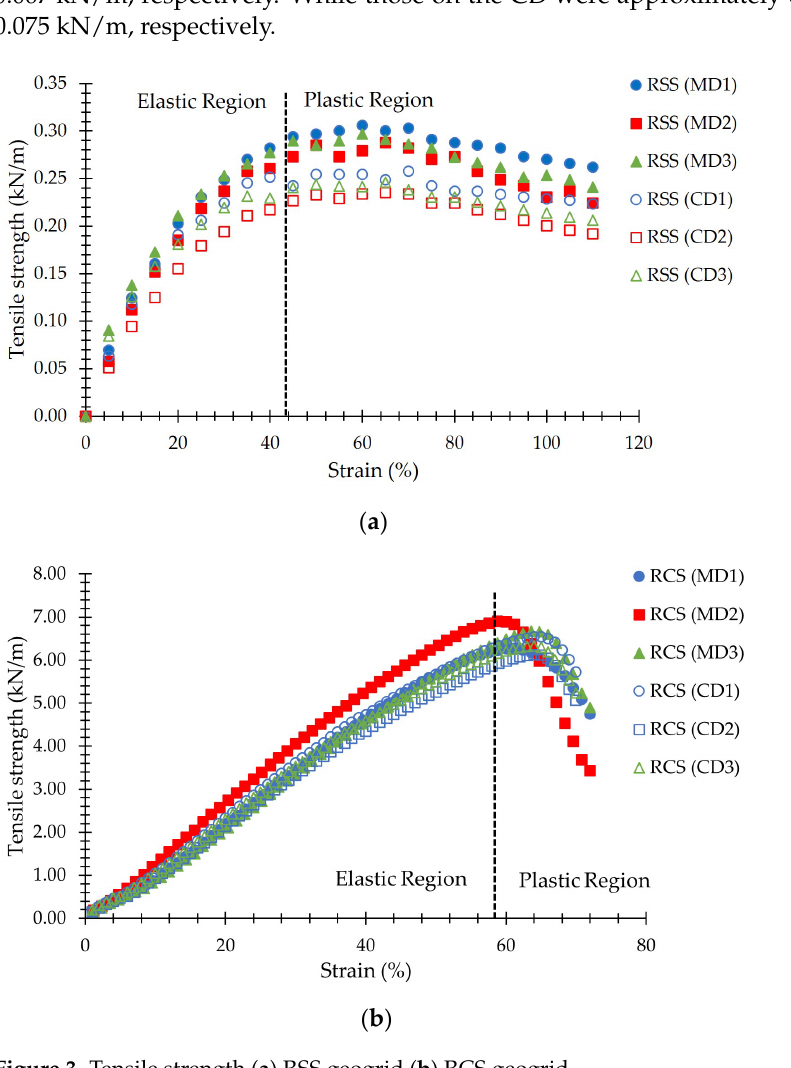
Table 1. Composition of rubber compound sheet.